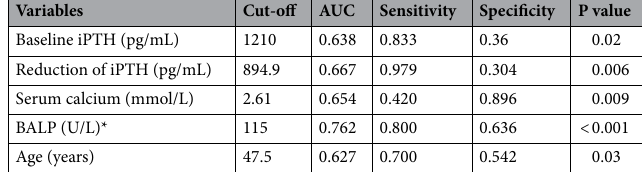
Table 4. ROC curves in patients with hypocalcemia. *AUC > 0.7.